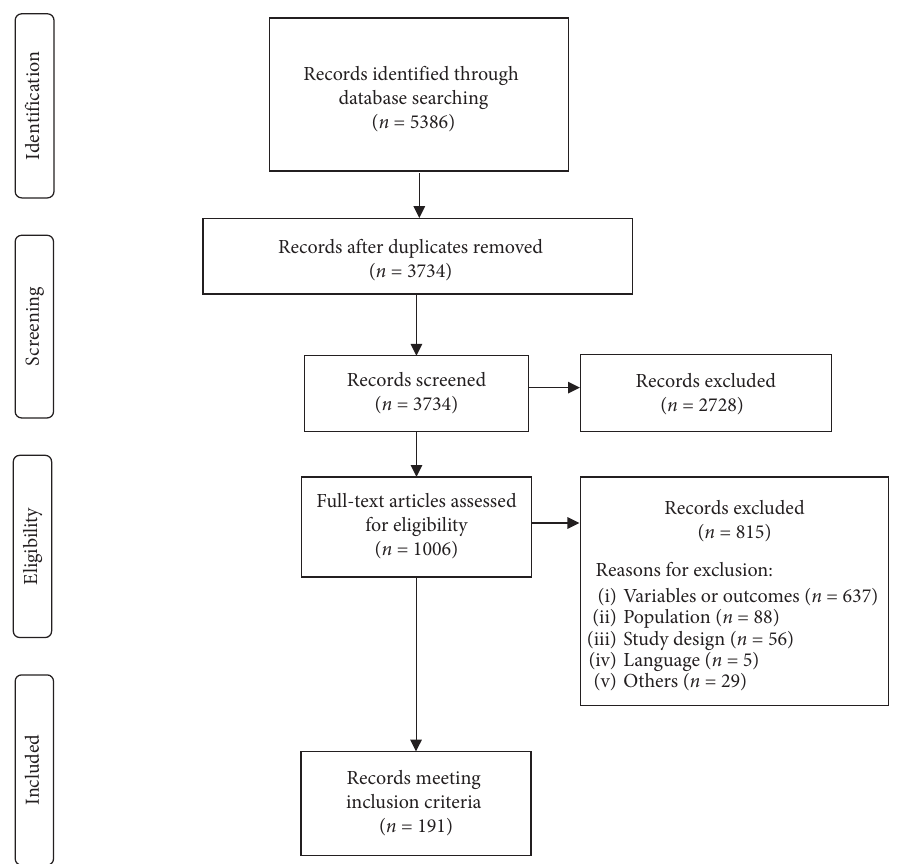
Figure 1: PRISMA flow